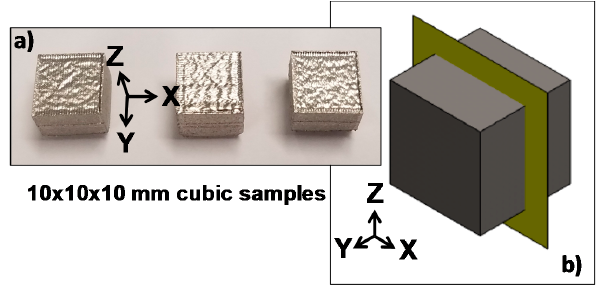
Figure 2. ( a ) Cubic samples prepared by the SLM process. ( b ) Cutting plane used as a reference to obtain the cross-section of each sample.